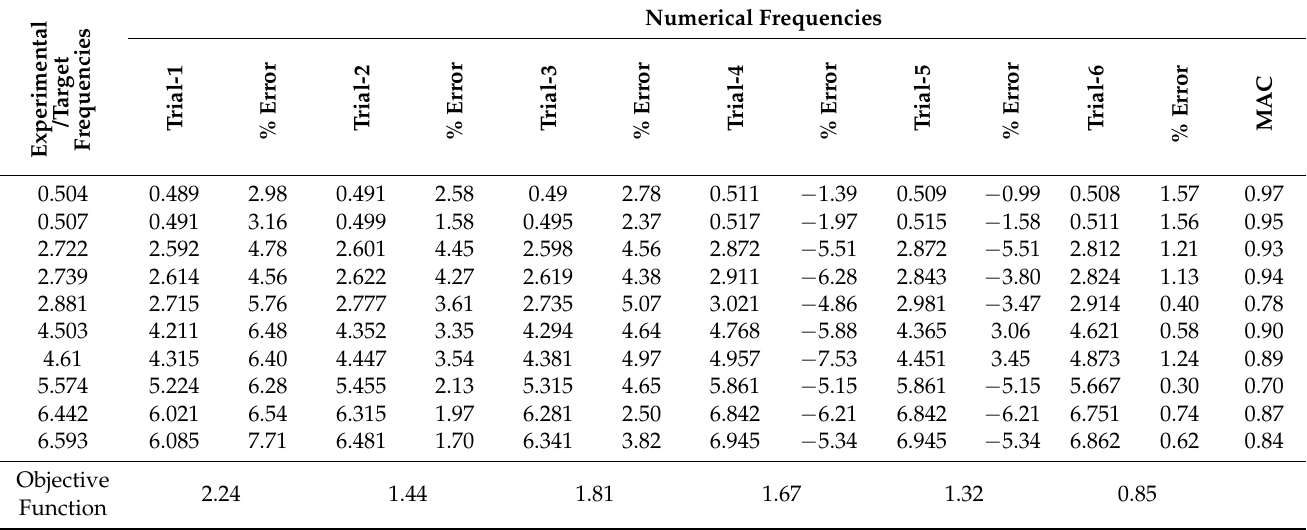
Table 6. Model updating